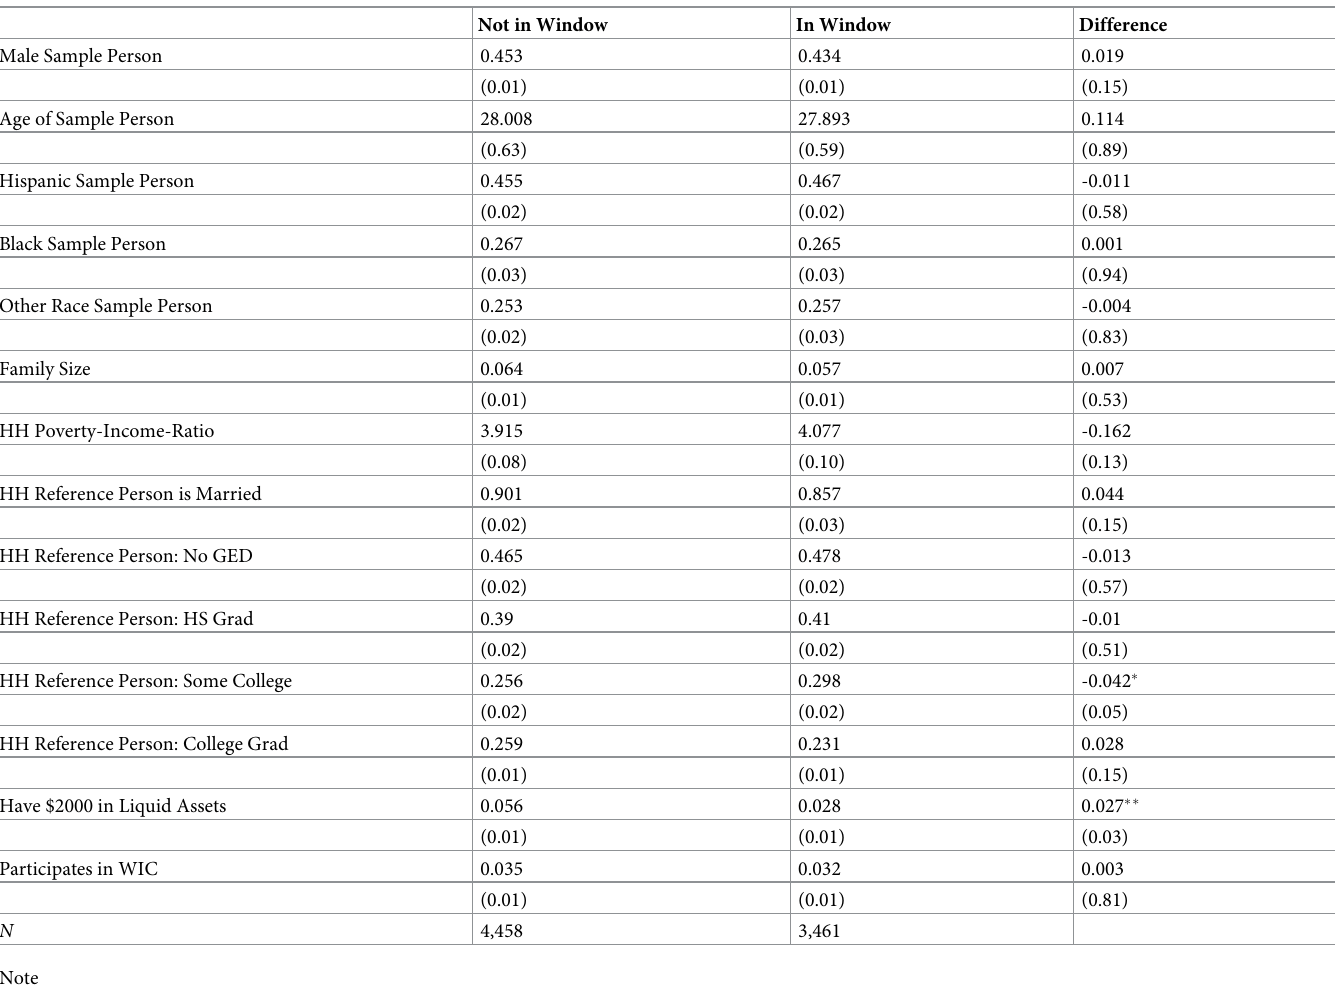
Table 1. Sample means of independent